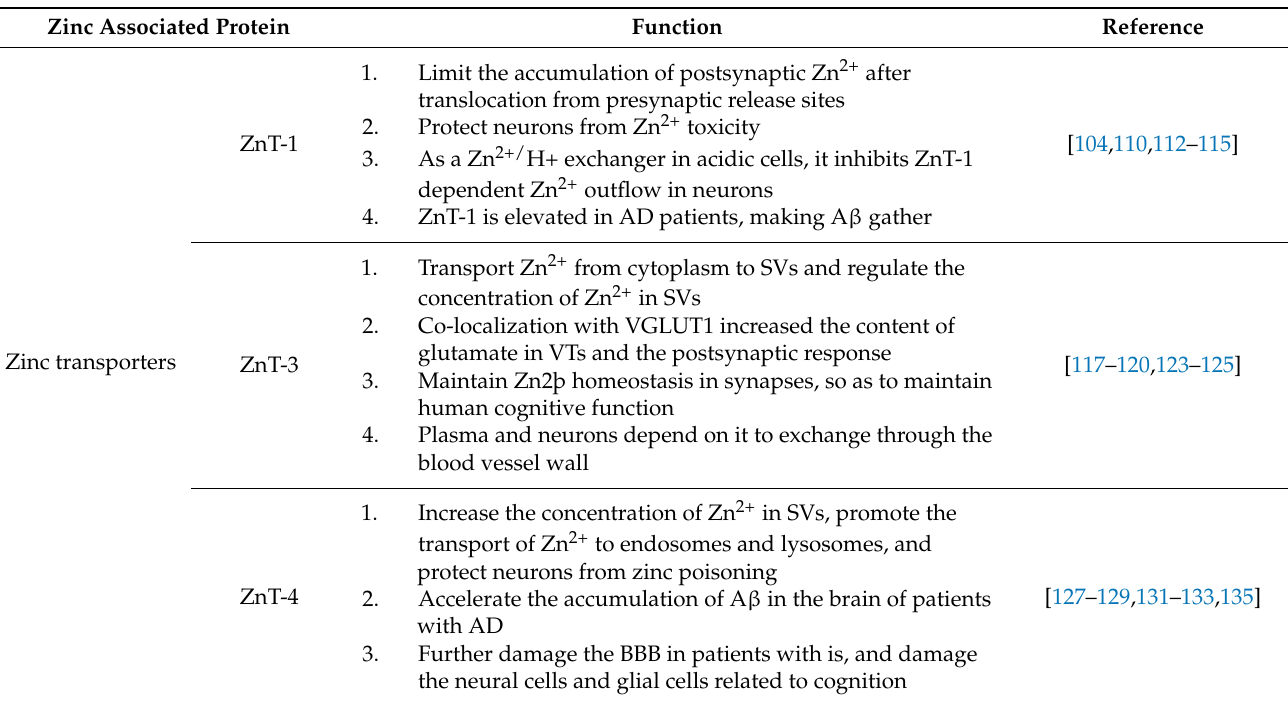
Table 1. The molecular mechanism and function of ZnTs and MTs in ARCD. Zinc Associated